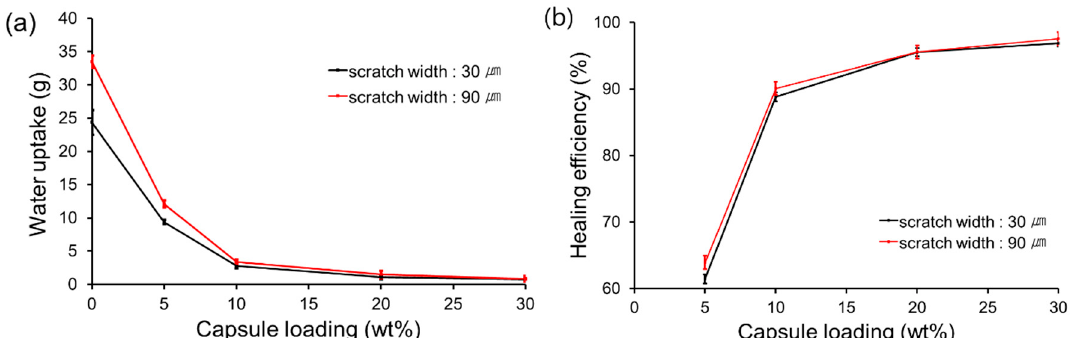
Figure 5. ( a ) Water uptake versus capsule loading of the coated mortar specimens. A scratch was applied on the surface of each coating at a width of 30 or 90 μ m; ( b ) Healing efficiency versus capsule loading of the self-healing coating calculated using Equation (2) and the data shown in ( a ).